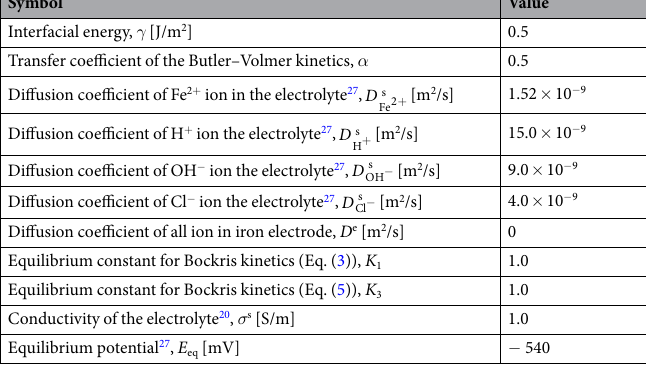
Table 1. Physical values and parameters used in the study.